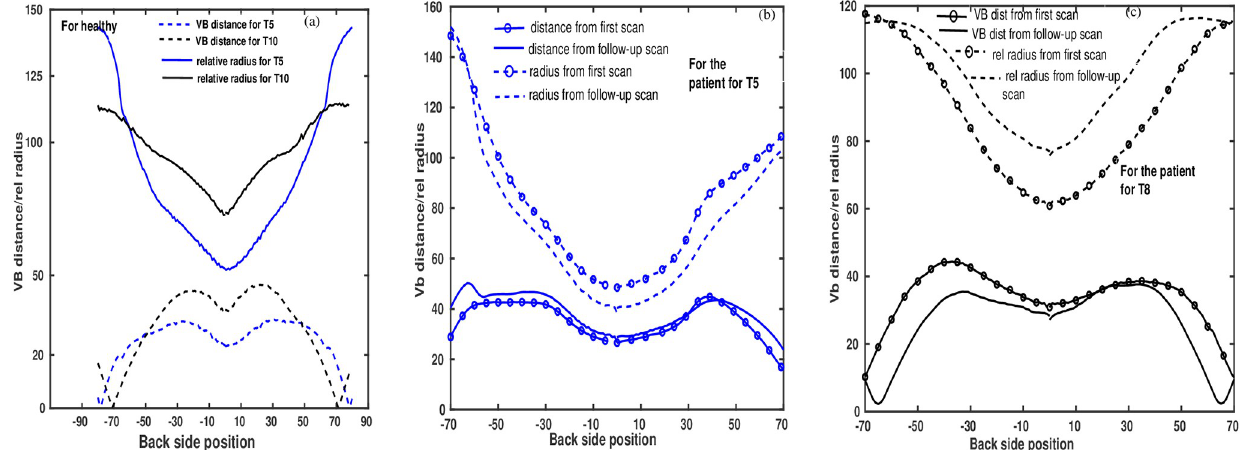
Fig 7. Back side asymmetries. Back side relative radius and distance from vertebral body line to contour points are presented, (a) from healthy control, (b) and (c) from the patient P1 at T5 level and T8 level, respectively.